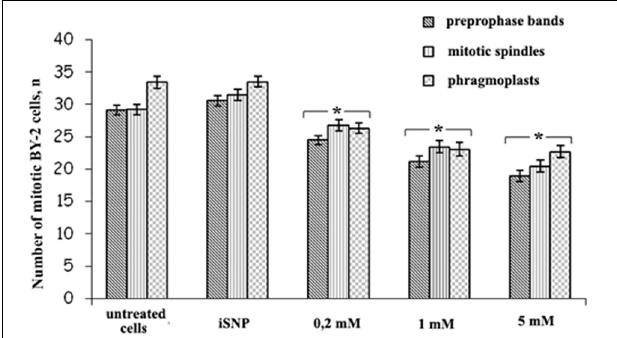
FIGURE 5 | The number of prepropase bands, mitotic spindles and phragmoplasts after SNP (200 μ M, 1 and 5mM) treatment for 3h. Light-inactivated SNP (iSNP) was used as a control. Cell number values are expressed as means ± SE ( n = 1000 cells from four independent experiments). Vertical bars represent the SE . Columns with asterisk are significantly different ( t -test, P < 0 . 001) from their controls (untreated and iSNP-treated cells). The number of GFP-labeled preprophase bands, mitotic spindles, and phragmoplats were double-checked by the number of pro-, ana-, meta-, and telophases revealed by